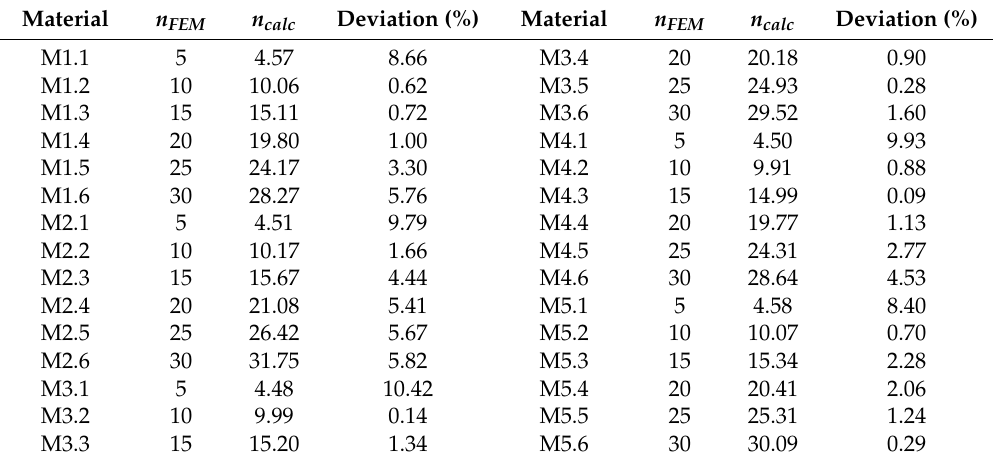
Table 4. Deviations between n calc and n FEM